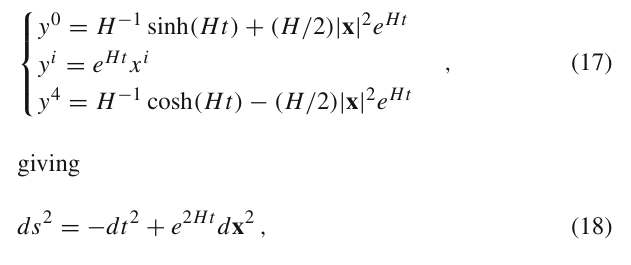
expressed in terms of a 5-dimensional Minkowski line